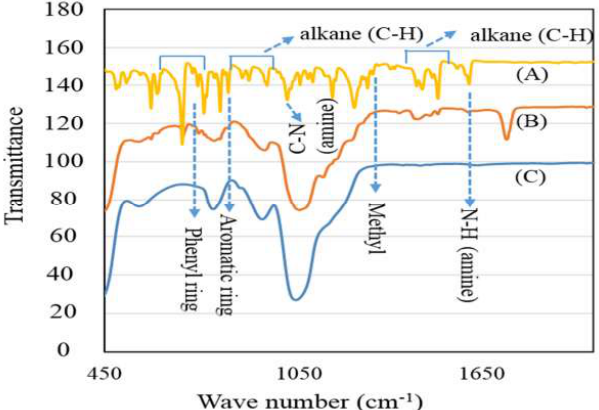
Figure 3. The functional group interactions of drug TAM ( A ), ( B ) PMMA-NR-Si-TAM and ( C ) silica, which were studied using FT-IR.